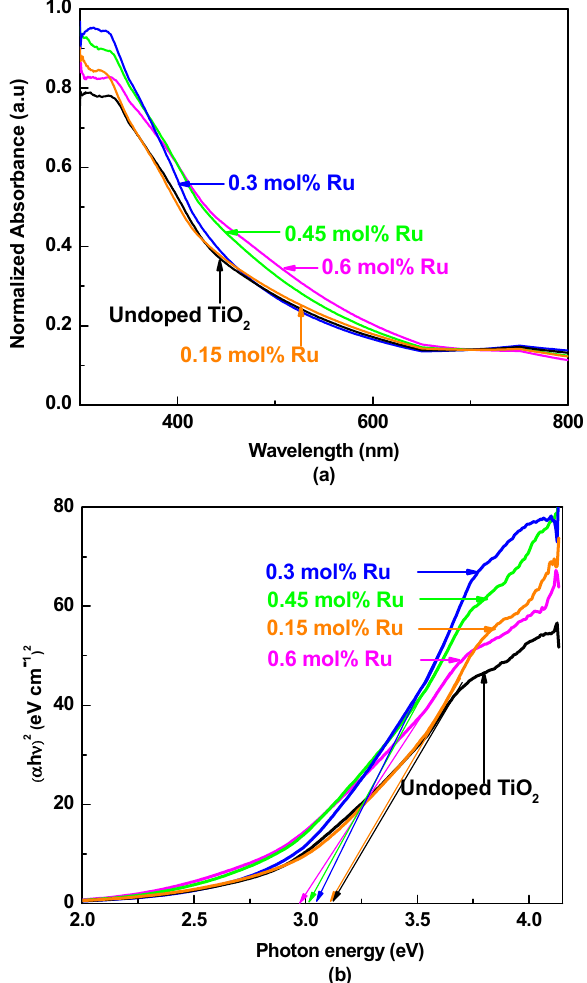
Figure 4. ( a ) UV–visible absorption spectra of undoped TiO 2 , 0.15, 0.3, 0.45 and 0.6 mol% Ru-doped TiO 2 nanomaterials; ( b ) Plot of ( α h υ ) 2 versus Photon energy for undoped TiO 2 , 0.15, 0.3, 0.45 and 0.6 mol% Ru-doped TiO 2 nanomaterials.